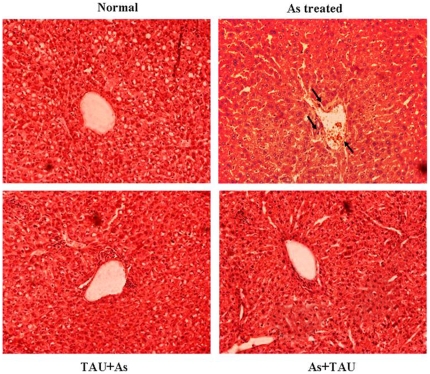
Haematoxylin and eosin stained liver section of normal, arsenic and taurine-treated rats (×10).Arrows indicate hepatocytes degeneration around the central vain in NaAsO2 intoxicated animals.